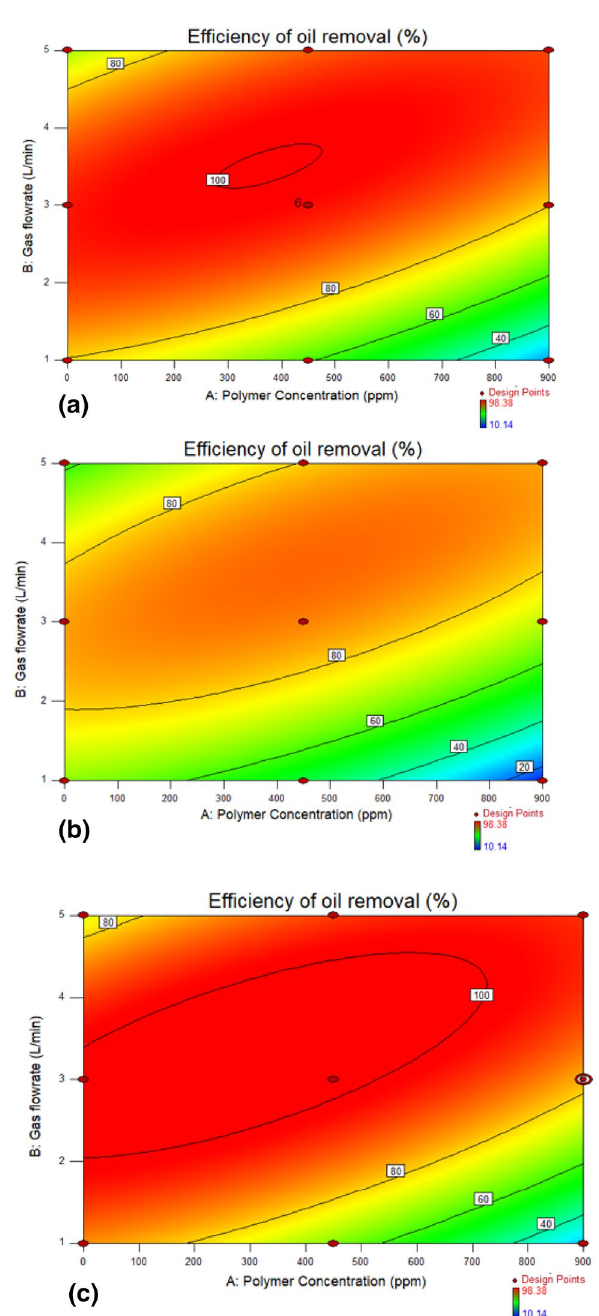
Fig. 4 The effects of polymer concentration and gas flowrate on the efficiency of oil removal at a 2 min of flotation duration, b 6 min of flotation duration, and c 10 min of flotation